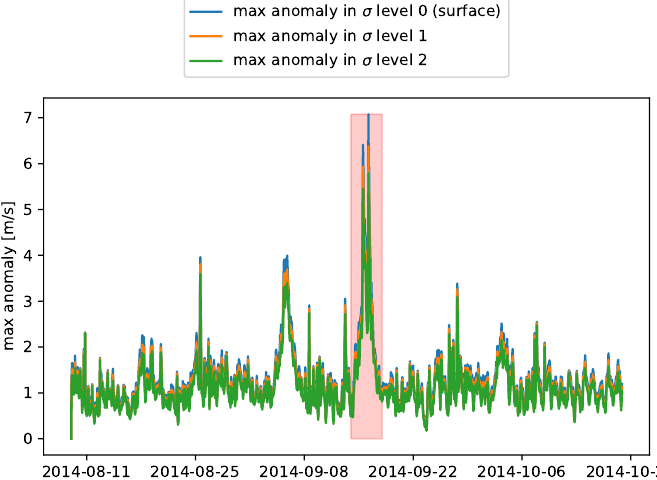
Figure 14. Maximum surface current anomaly time series for the three topmost model layers. All dates in UTC.